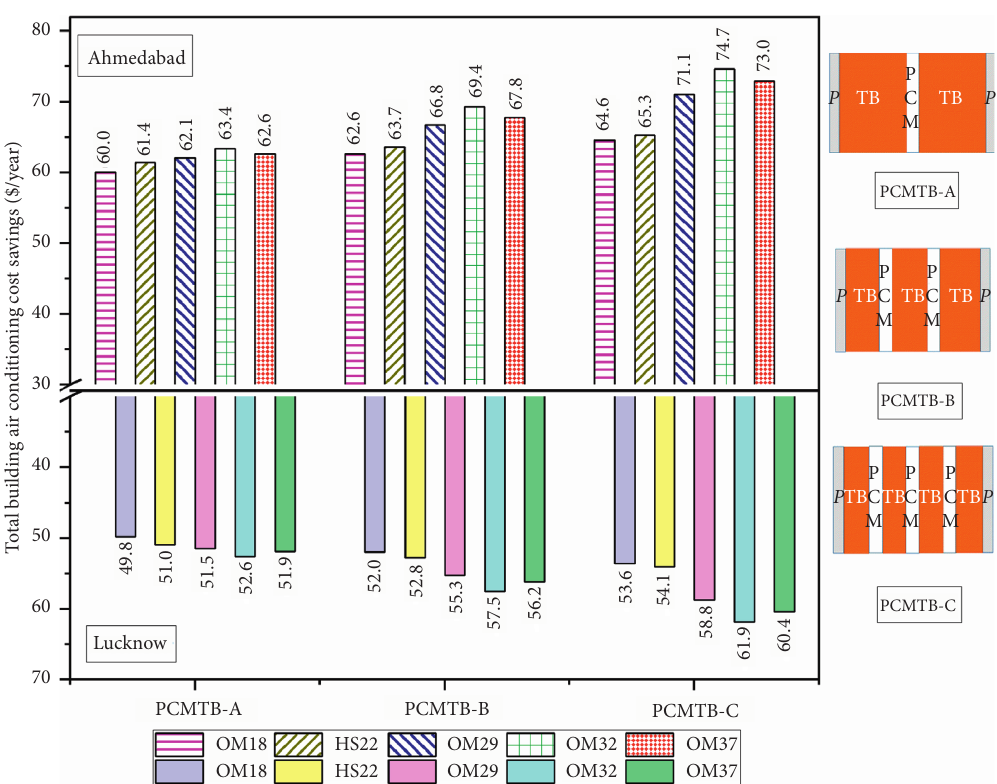
Figure 7: Total building air-conditioning cost saving of terracotta brick buildings integrated with PCMs in Ahmedabad and